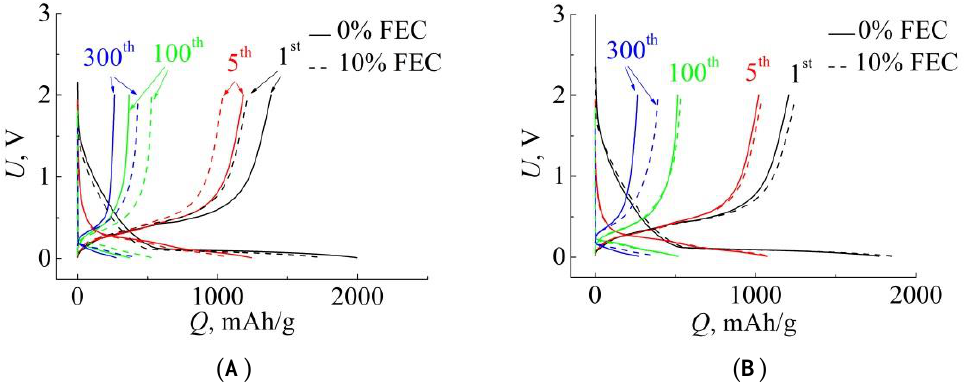
Figure 4. Charge – discharge voltage profiles for samples with and without FEC in pairs ( A , B ) for 1, 5, 100, 300th cycles. The current density during the lithiation/delithiation of the electrodes was 100 mA/g.